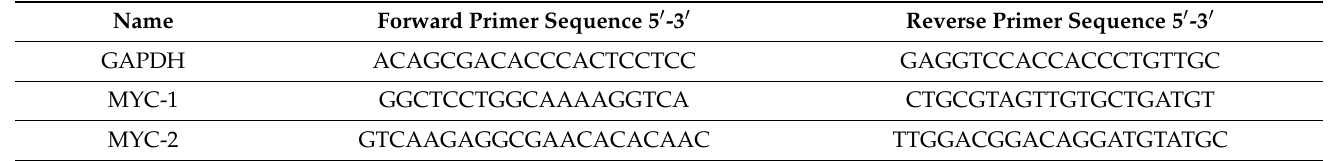
Table 1. Primers used for